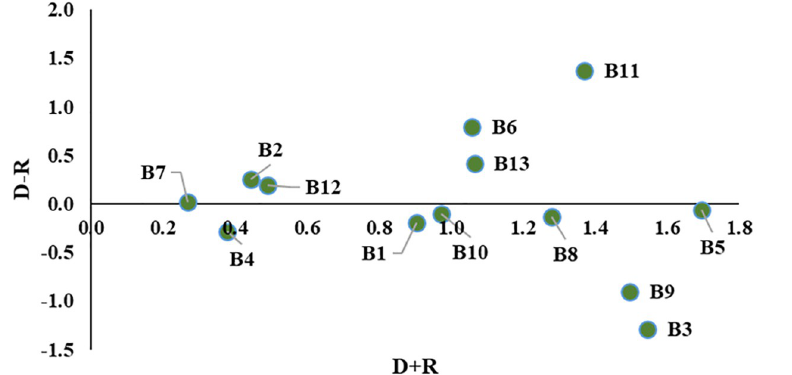
Fig 7. The relationships among the barriers for sensitivity analysis Case 1.